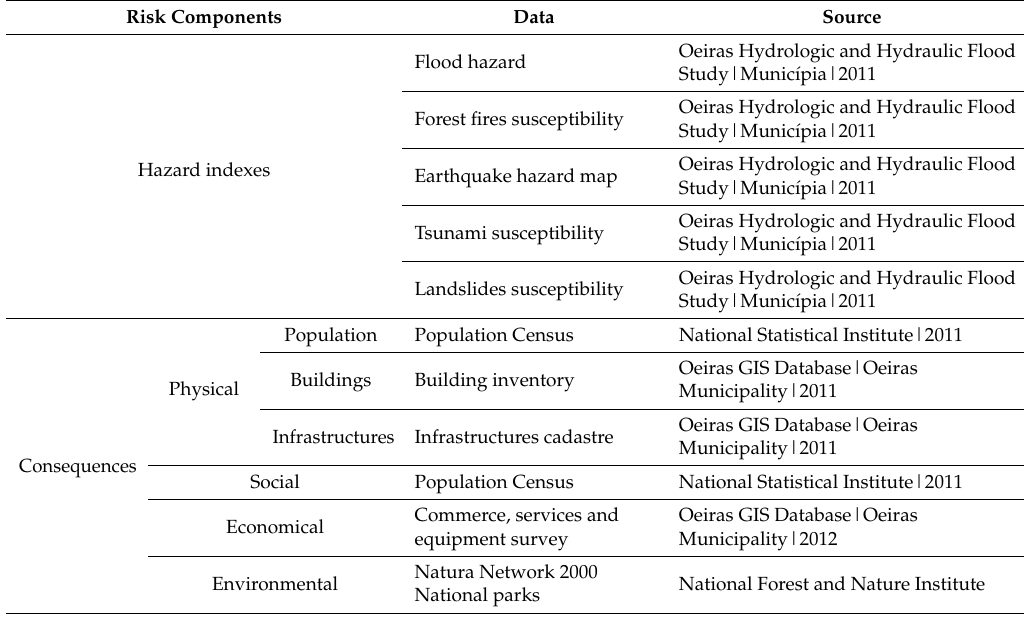
Table 2. Input data synthesis.